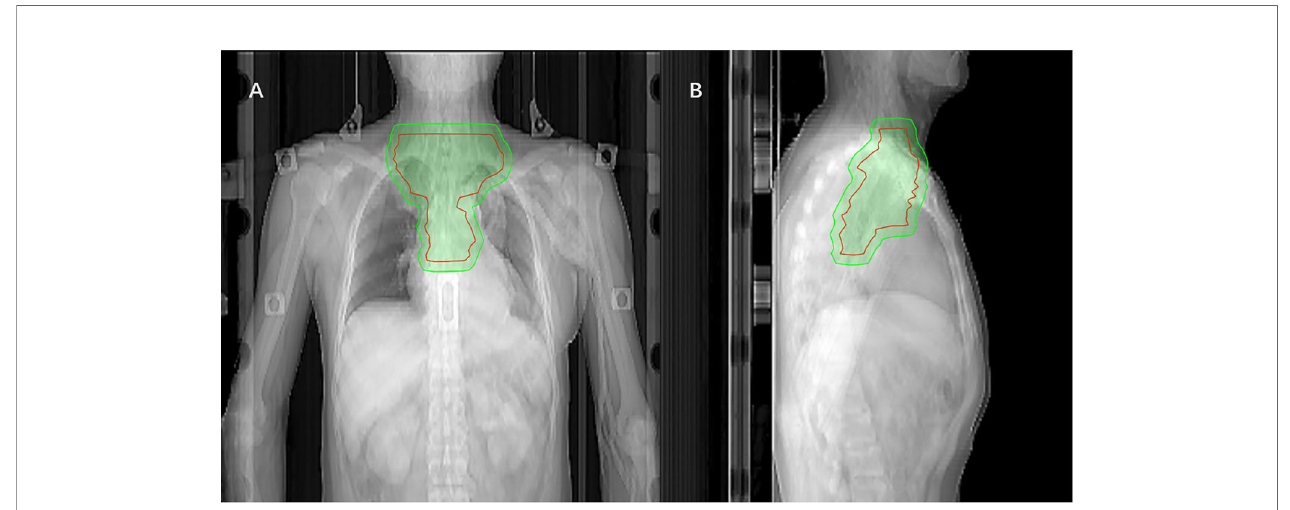
FIGURE 1 | Coronal (A) and sagittal (B) views of the CTV (red mark) of postoperative radiotherapy using the IMRT(The green area is the